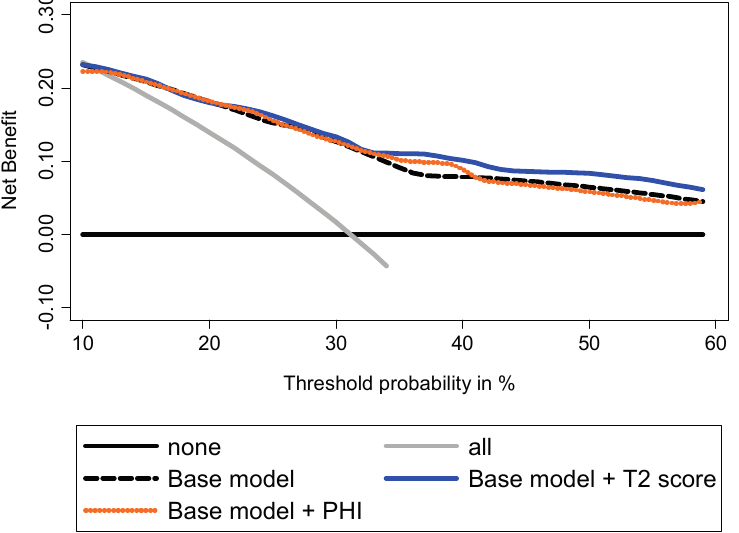
Figure 7. Evaluation of the ability of PHI and T2 score to predict extracapsular extension using decision curve analysis. Base model: age, DRE findings, total serum PSA, and Gleason sum at